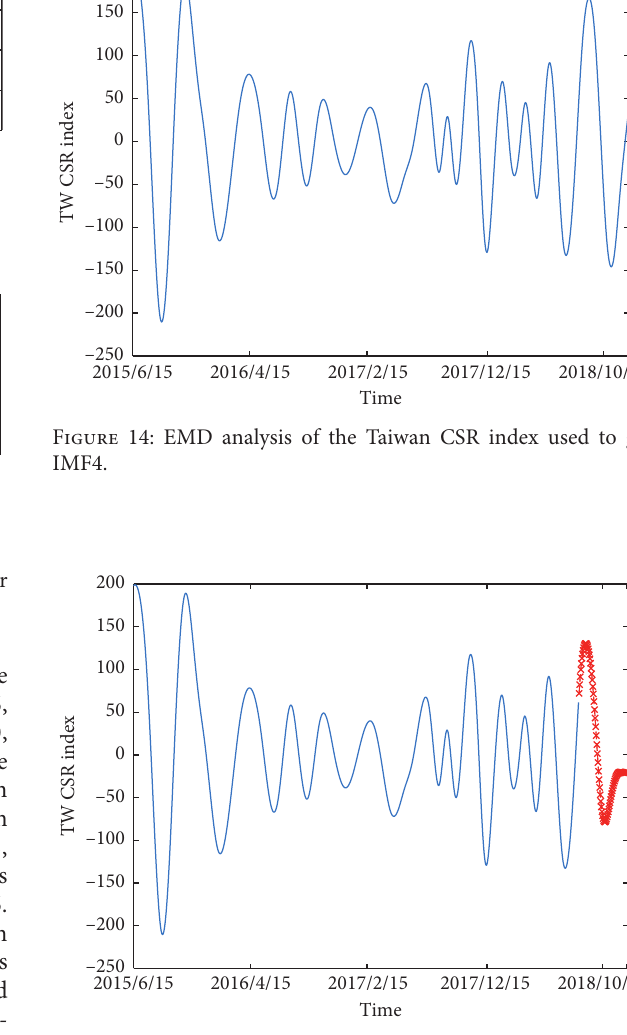
Figure 15: LSTM prediction results for